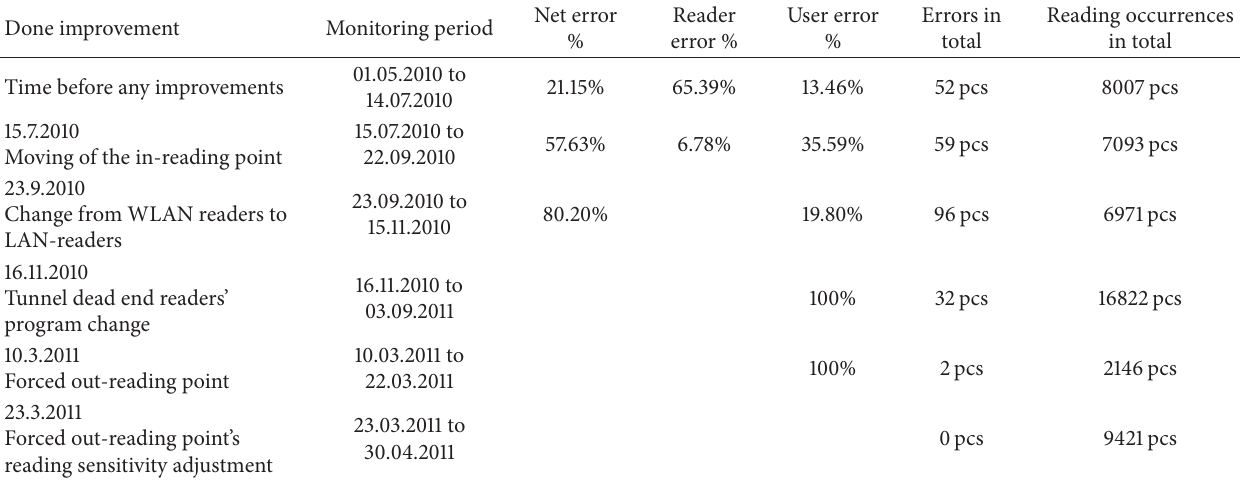
Table 1: The reading occurrences and the amount of errors during the monitoring